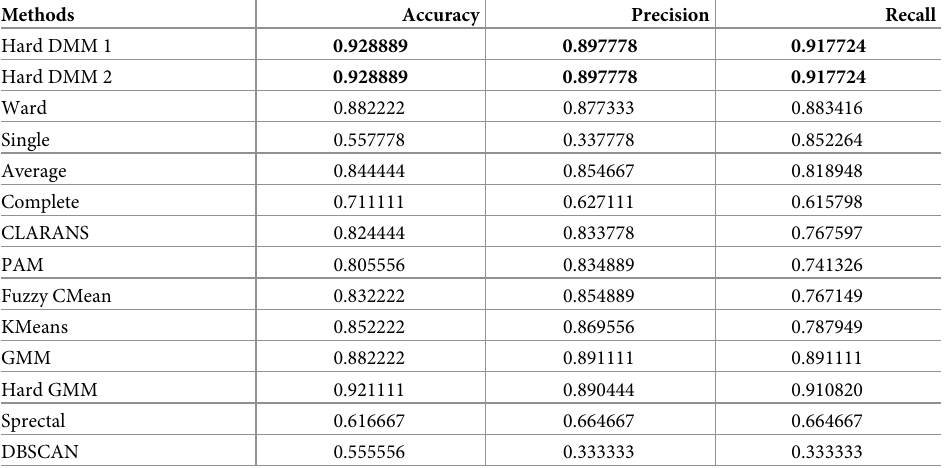
Table 1. Accuracy, precision and recall of different clustering algorithms on data generated under scheme 1.